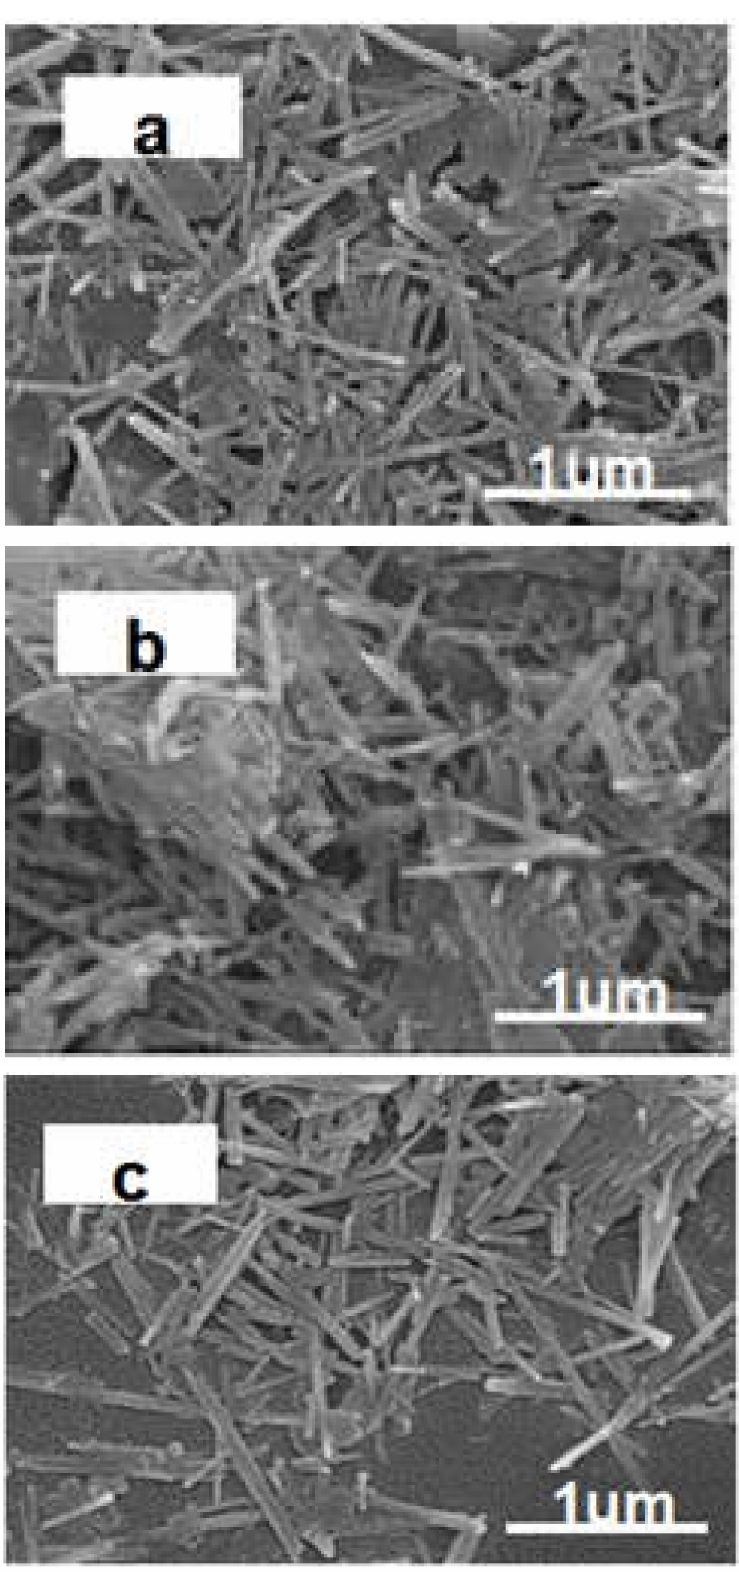
Figure 2. Scanning electron microscopic images of different catalysts: ( a ) Mn 8 /PG, ( b ) Mn 8 /PG-S, and ( c ) Mn 8